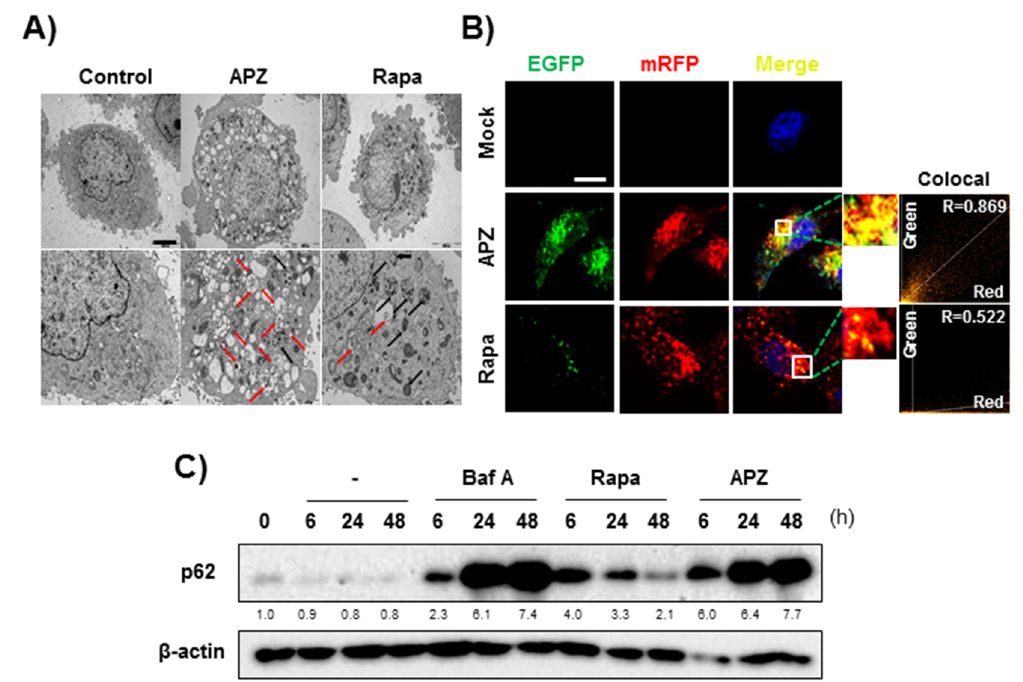
Figure 1. Autophagonizer (APZ) inhibits autophagic flux. ( A ) TEM images of APZ (5 µ M)- and rapamycin (10 µ M)-induced autophagic vacuoles after 24 h of treatment. Red arrows indicate autophagosomes containing multiple double-membrane structures. Black arrows indicate autolysosomes containing single-membrane, multilamellar structures. Scale bar, 10 µ m. ( B ) Autophagic flux evaluation in human cervical cancer (HeLa) cells using monomeric red fluorescent protein (mCherry)-green fluorescent protein (GFP) LC3in the presence of each compound. Representative images of merged channels are shown; scale bar, 10 µ m. Pearson coefficient for the colocalization analysis is shown. ( C ) p62 levels after compound treatment for 6, 24, and 48 h. APZ induced accumulation of p62 for up to 48 h, similar to bafilomycin A (10 nM). More details of western blot, please view at the supplementary materials.